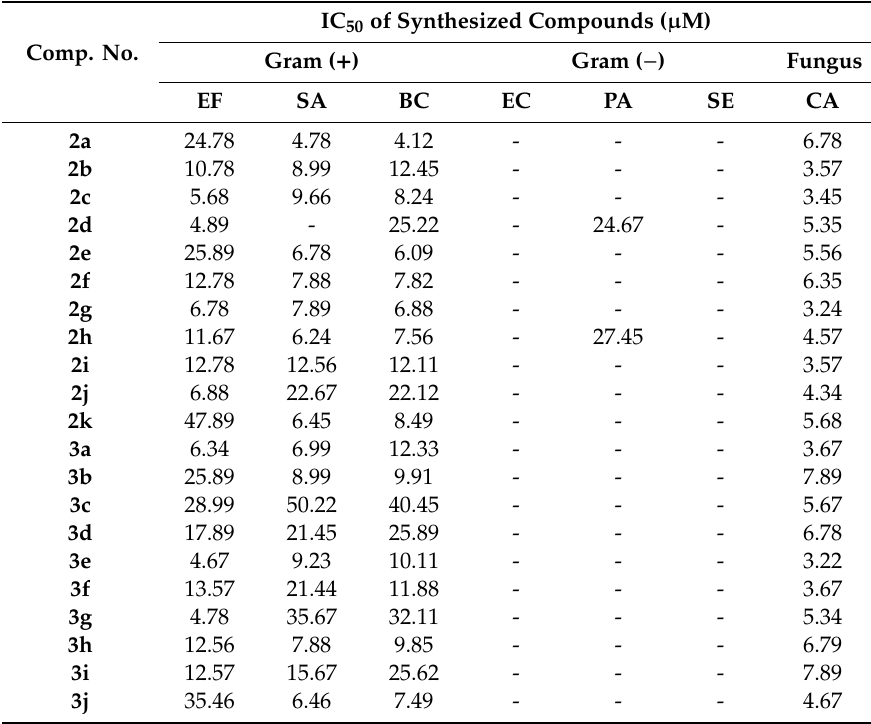
Table 3. IC 50 of synthesized thiosemicarbazones 2a – k and 3a – j .